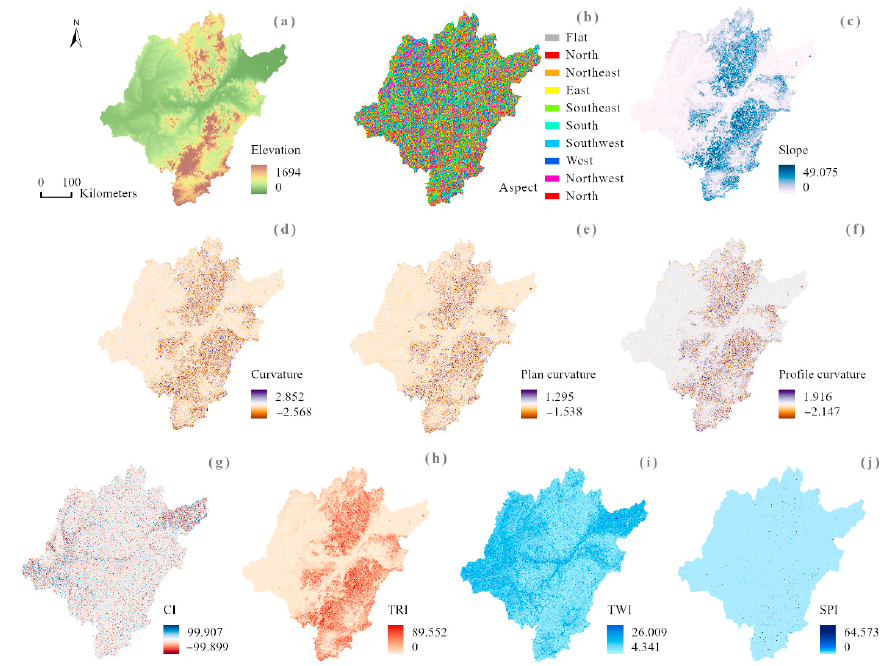
Figure 2. Map of conditioning factors: ( a ) elevation, ( b ) aspect, ( c ) slope, ( d ) curvature, ( e ) plan curvature, ( f ) profile curvature, ( g ) CI, ( h ) TRI, ( i ) TWI, and ( j ) SPI. A river represents the main discharge route for a flood. The distance from rivers and the stream density of the basin play a major role in the distribution and magnitude of flash floods [17,45]. Linear river data were obtained from the National Geomatics Center of China and used to calculate the stream density and distance to rivers data (Figure 3a,b).